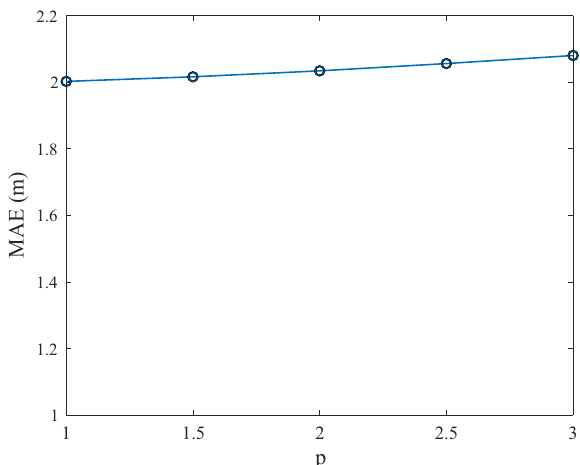
Figure 8. MAE of interpolation using IDW for different p with